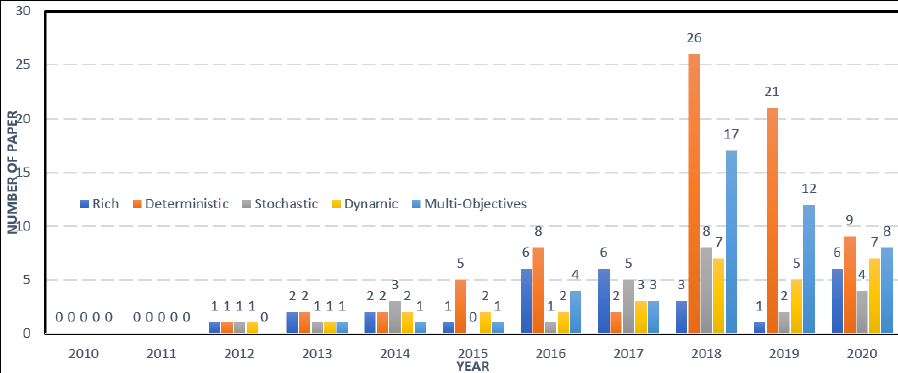
Figure 38. Modelling Description Applied in Literature According to Year of